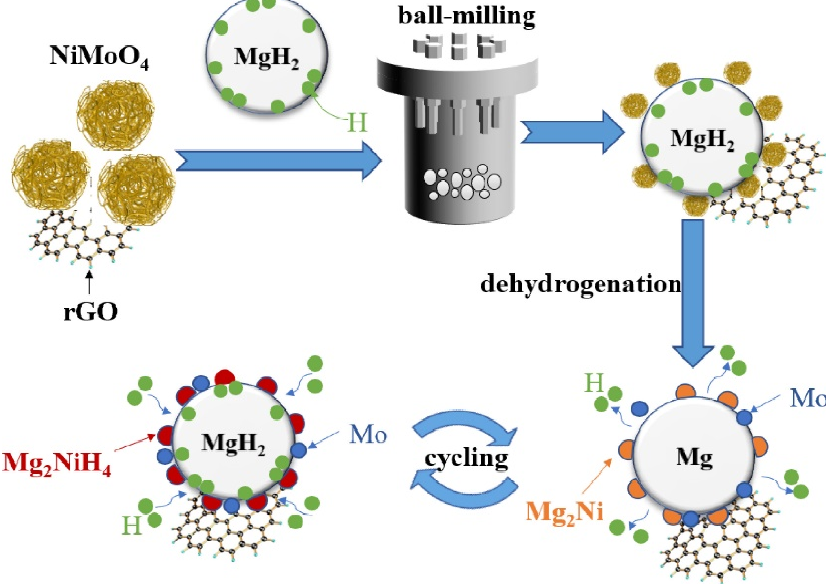
Figure 5. Schematic diagram of the action mechanism of NiMoO 4 and rGO co-catalyzing MgH 2 par- ticles. Copyright 2022, Elsevier. Reproduced with permission from [73].